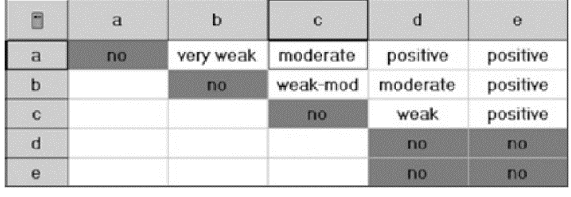
Figure 4: Example of MACBETH